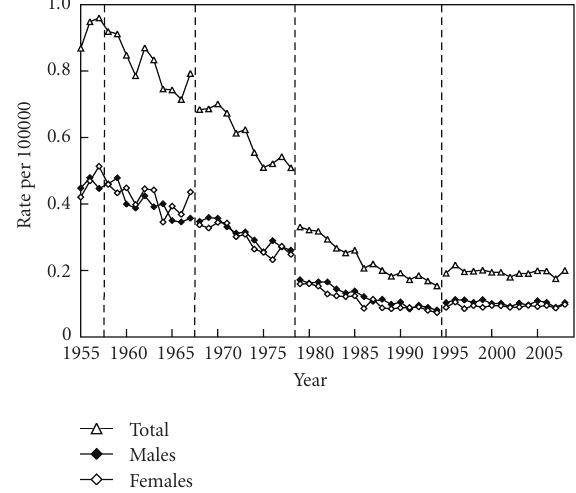
Figure 2: Annual trends in age-standardized death rates of NMSC in Japan (1955 ∼ 2008), modified from Ohtsuka and Nagamatsu